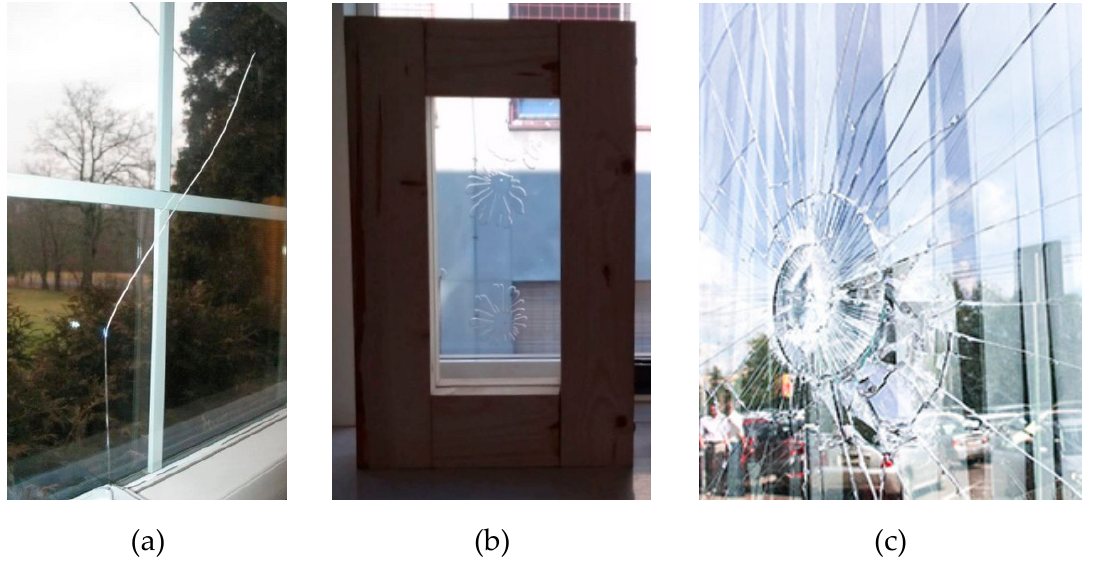
Figure 4. Examples of relevant damage in glass: ( a ) thermal shock; ( b ) melting of the interlayer foil, due to high temperature exposure (Zagreb University, Croatia–VETROLIGNUM Project); ( c ) fracture due to impact.